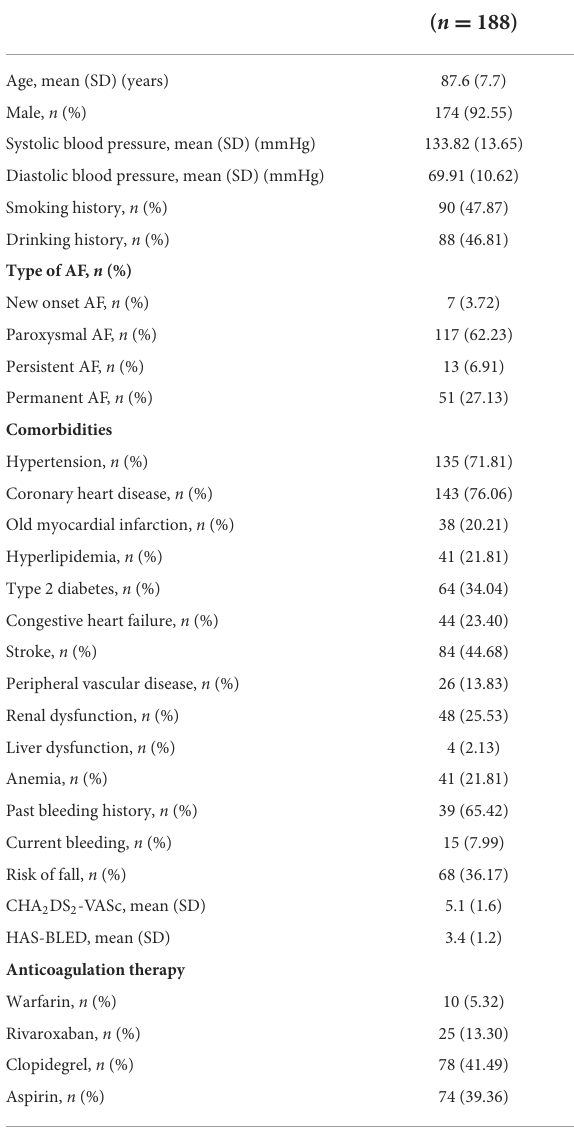
TABLE 1 Baseline clinical characteristics of 188 elderly patients with AF at high risk of thromboembolism and bleeding. Characteristic Patients with AF